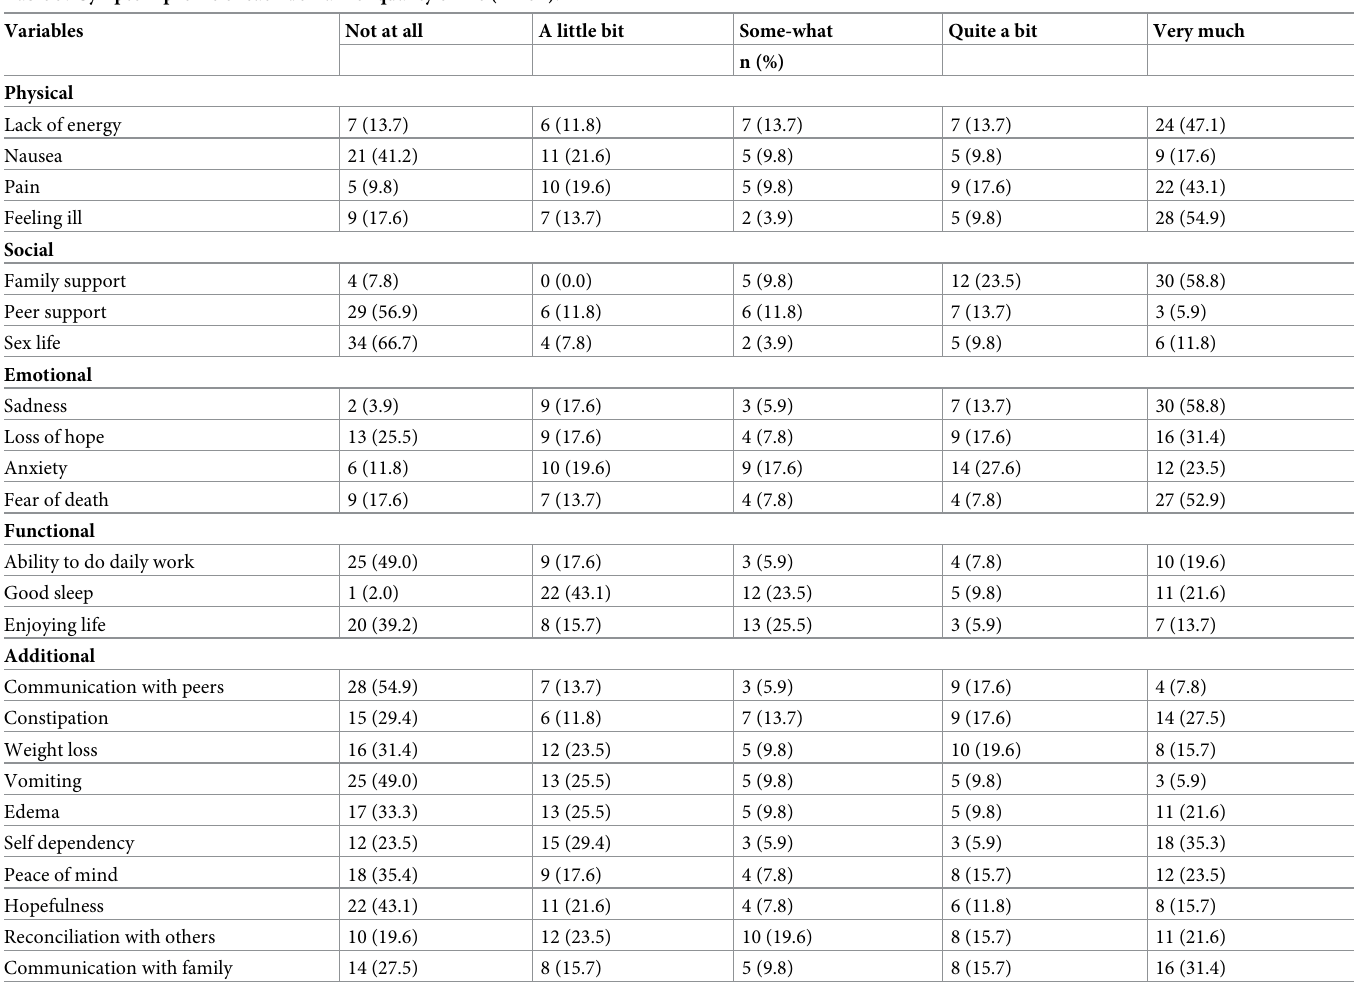
Table 5. Symptom profile of each domain of quality of life (n = 51).